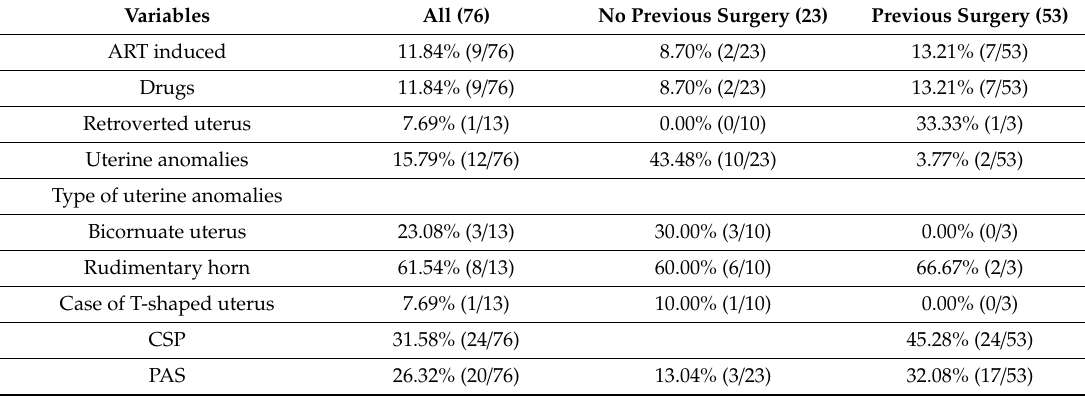
Table 2. Aggregated data considering associated factors with first-trimester uterine rupture and histological findings after surgical